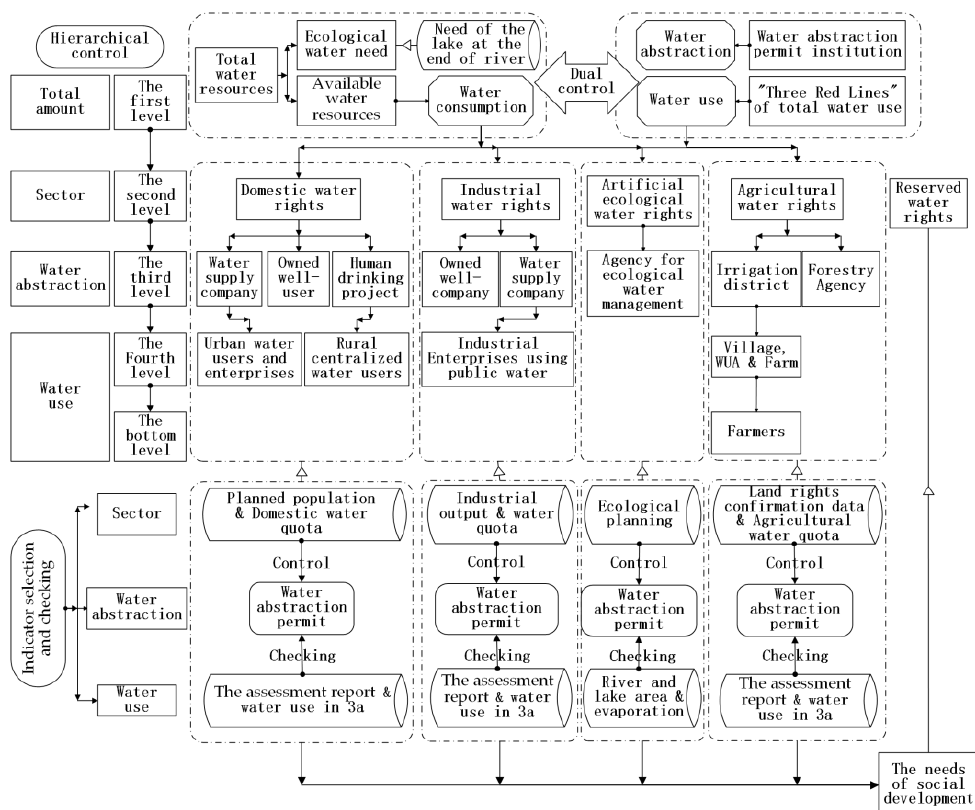
Figure 1. Framework and indicator selection of water rights confirmation.